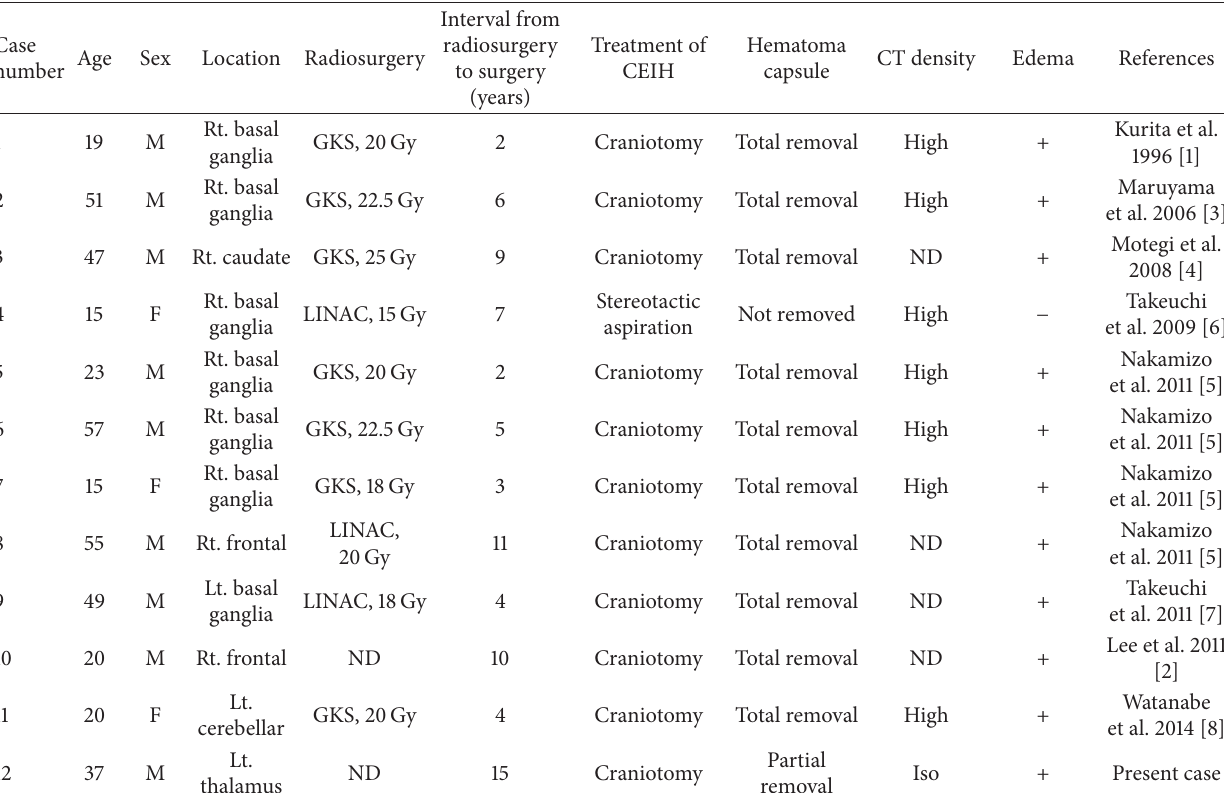
Table 1: Patients with chronic encapsulated intracerebral hematoma (CEIH) following radiosurgery for arteriovenous malformation. Case